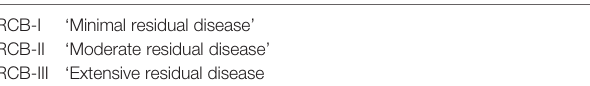
TABLE 5 | Residual cancer burden